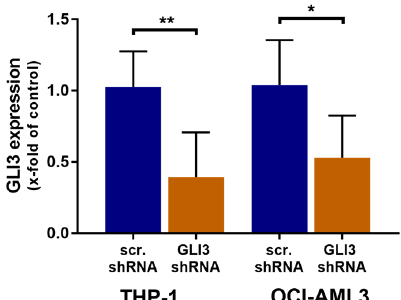
Figure 3. E ffi ciency of GLI3 knockdown in AML cell lines THP-1 and OCI-AML3. GLI3 mRNA levels were measured by RT-qPCR following lentiviral transduction with two distinct shRNA targeting GLI3 . The expression of GLI3 was normalized to that in control cells transduced with a scrambled control shRNA; * p < 0.05 and ** p < 0.01 in Welch’s t -test.